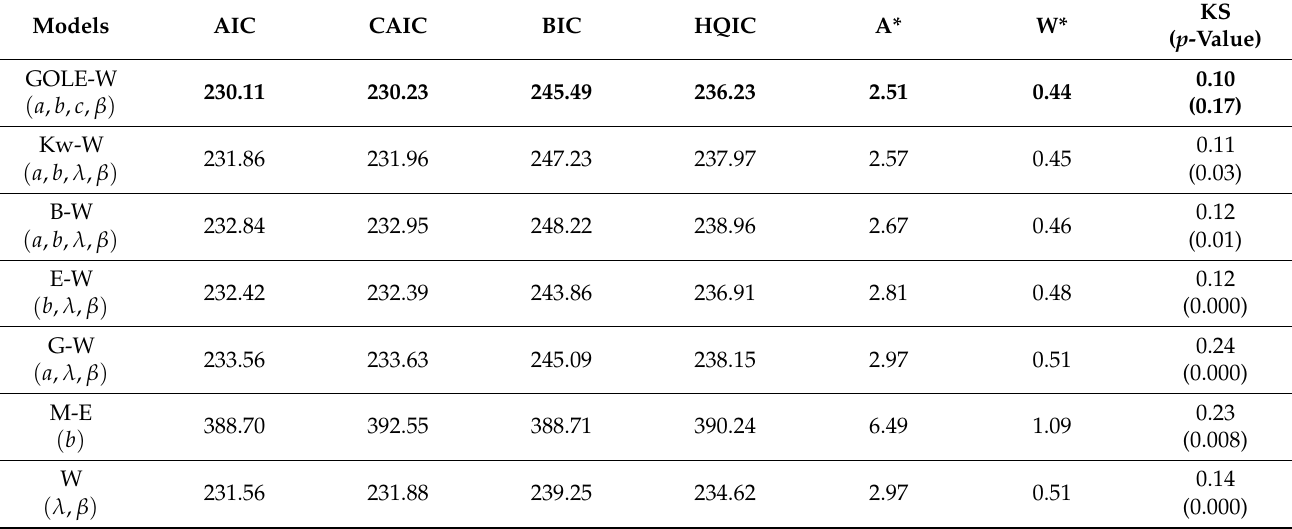
Table 8. The AIC, CAIC, BIC, HQIC, A*, W* and KS ( p -value) values for data set I.